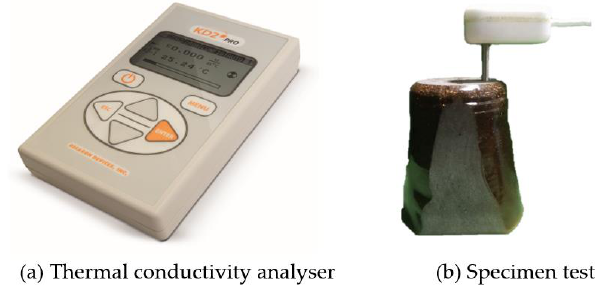
Figure 10. Thermal conductivity test.